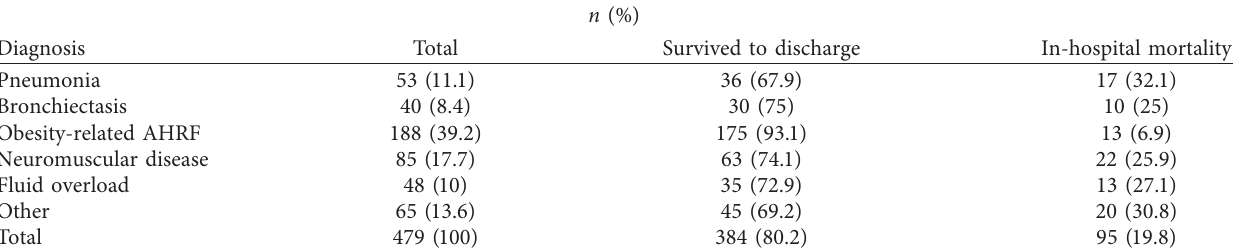
Table 2: Prevalence of conditions causing